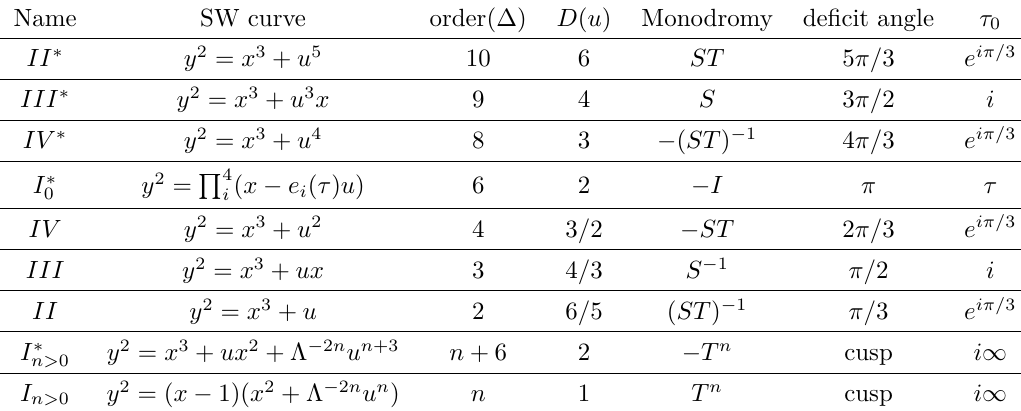
Table 3 . The geometries around a singularity in the Coulomb branch are listed. This table is taken from [57]. The Seiberg-Witten curve around the singularity is written in the second column where the singularity is at u = 0 . The third column, order (∆) , is the order of zero of the discriminant. The fourth column, D ( u ) , is the scaling dimension of u . The fifth column is the monodromy up to SL(2 , Z ) conjugation, where S and T are given in (3.8). The sixth column is the deficit angle in Coulomb branch geometry, and the last column is the value of τ at the singular point. The last two rows correspond to the IR free theories while the others are